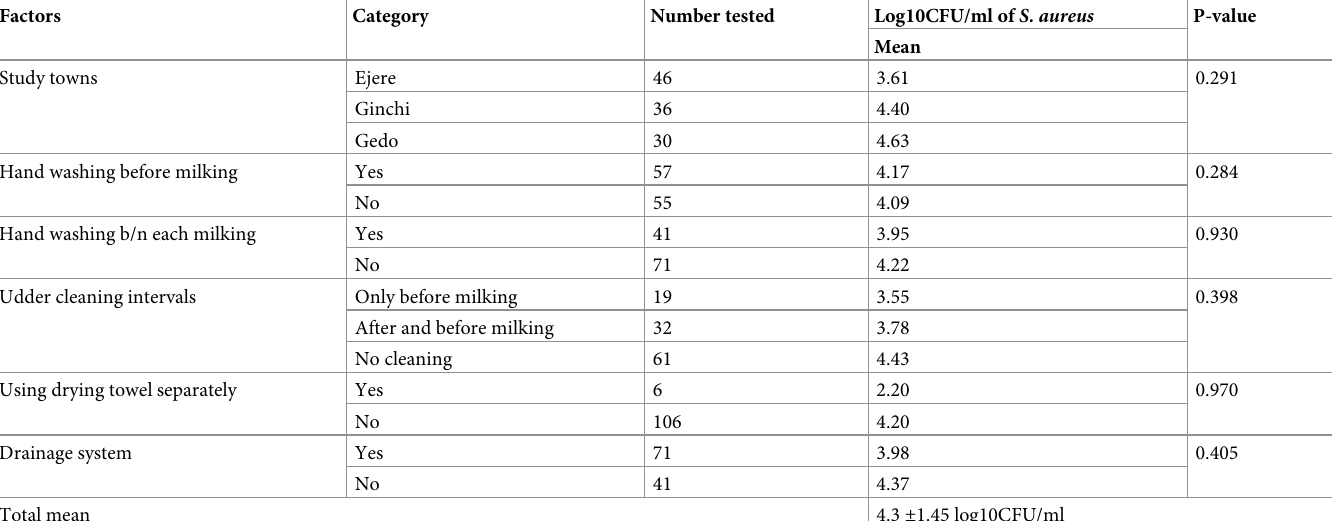
Table 3. The factors contributing to the occurrence of S . aureus in raw milk in the study area. Factors